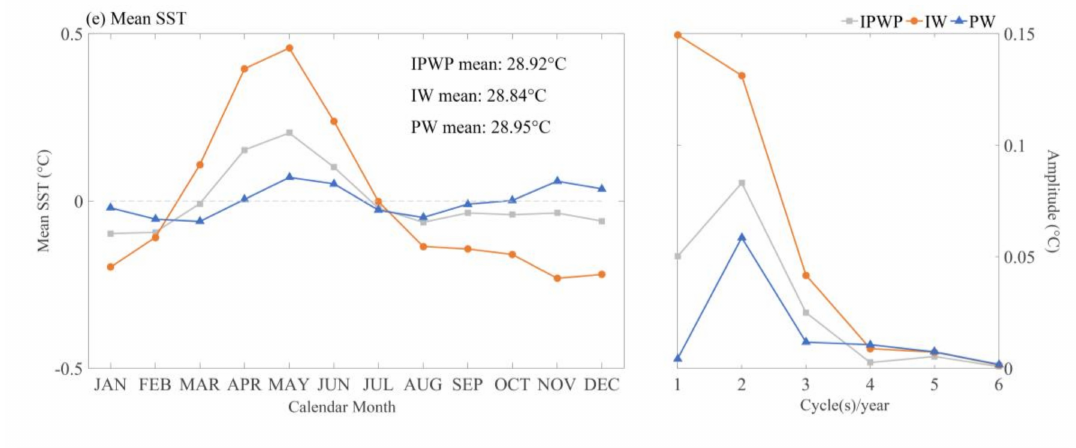
Figure 4. Annual cycles and harmonics of ( a ) Size variation; ( b ) Zonal center movement; ( c ) Meridional center movement; ( d ) Maximum SST; ( e ) Mean SST of the IPWP, IW and PW, respectively.